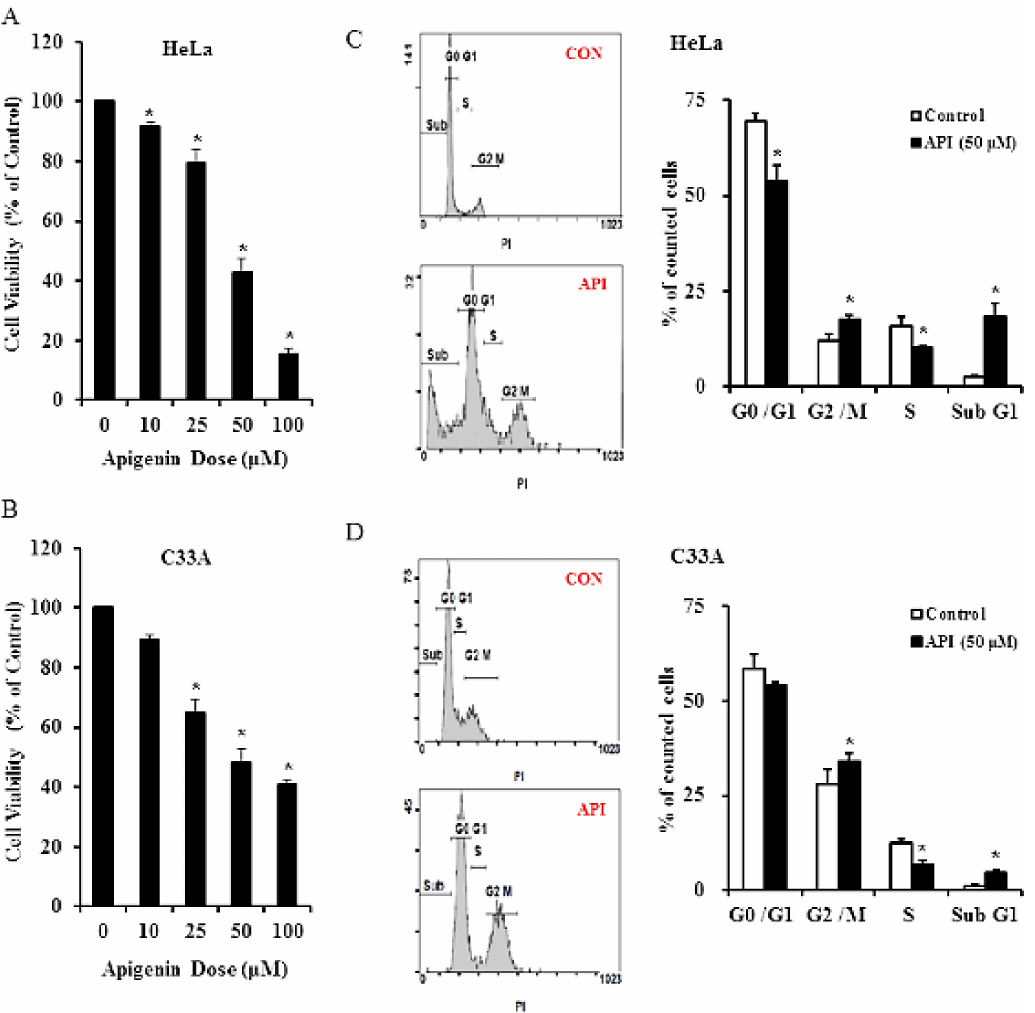
Figure 1. Apigenin inhibits human cervical cancer cell viability and induces cell cycle arrest. HeLa ( A ) and C33A ( B ) cells were treated with increasing doses of apigenin for 24 h. Cell viability was determined using PrestoBlue™ cell viability reagent. HeLa ( C ) and C33A ( D ) cells were treated with or without 50 µ M of apigenin for 24 h, and an estimation of the cell cycle phase distribution (G0/G1, S, and G2/M) was determined by PI staining via flow cytometry, followed by quantification. Data are presented as the mean ± SD of at least three independent experiments. * p < 0.05 indicates a significant difference as compared with the corresponding control. CON, 0.1% DMSO; API (50 µ M), 50 µ M